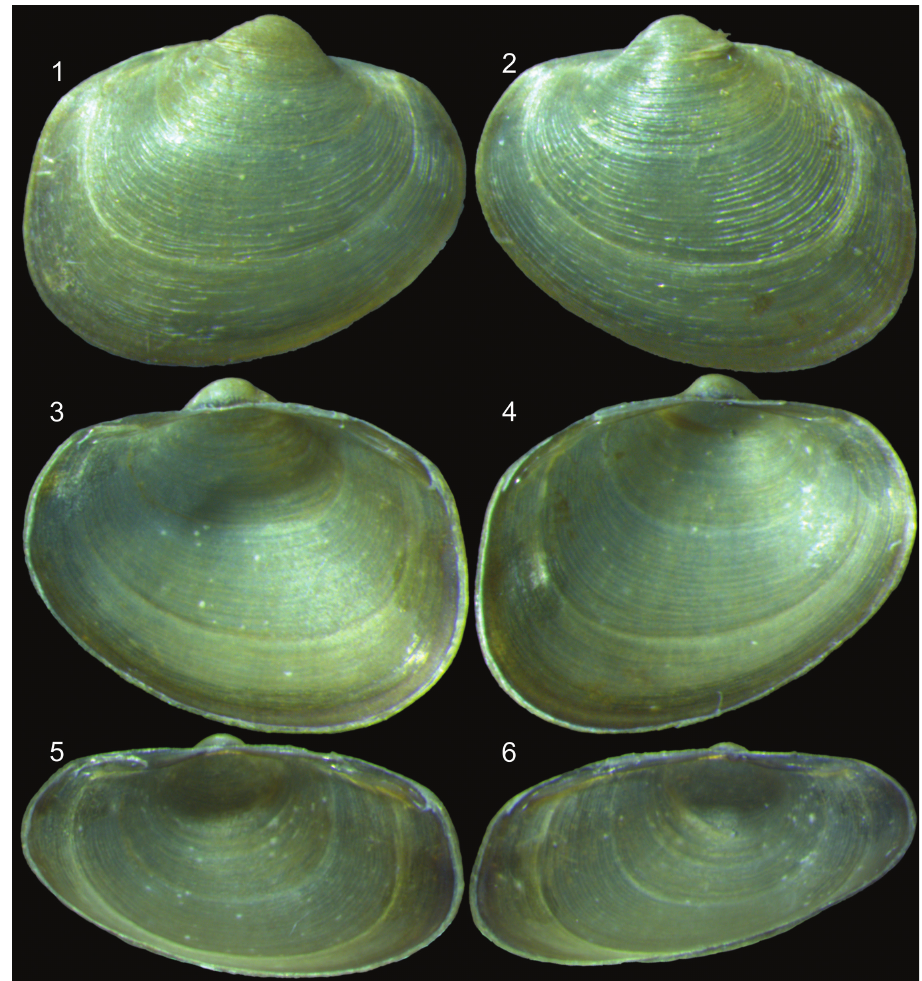
Figures 1–6. Eupera troglobia holotype MZSP 155717 shell (L 4.3 mm), right valve in left column, left valve in right column 1 outer right view 2 outer left view 3 inner left view 4 inner right view 5 inner left- slightly ventral view 6 inner right-slightly ventral